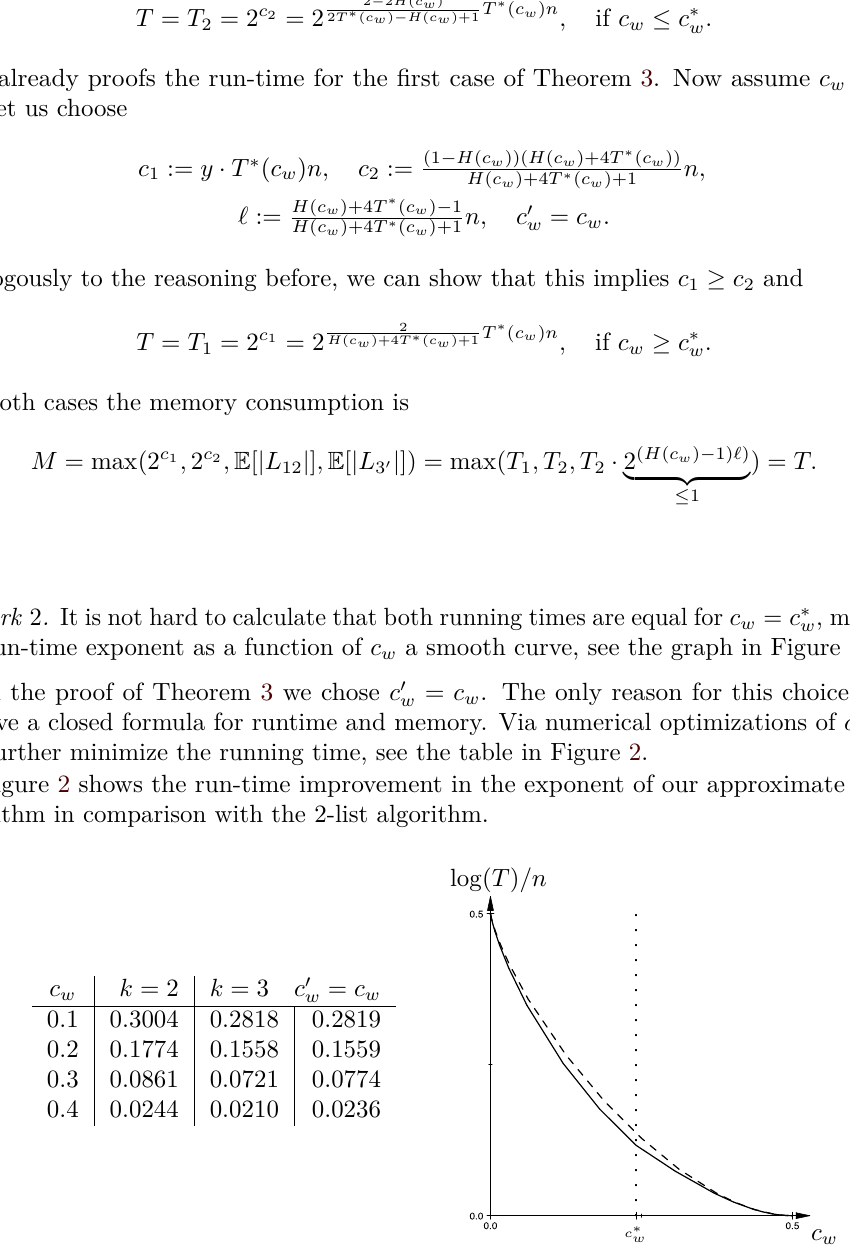
Figure 2: Running time exponent log T to its approximate 2-list counterpart